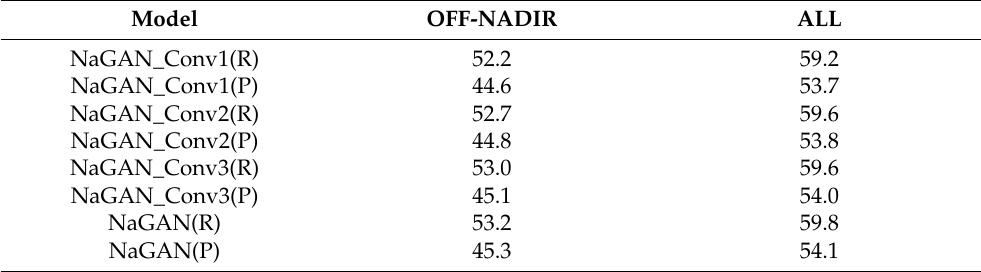
Table 3. Performance comparisons on feature generation from different-level layers on SpaceNet.